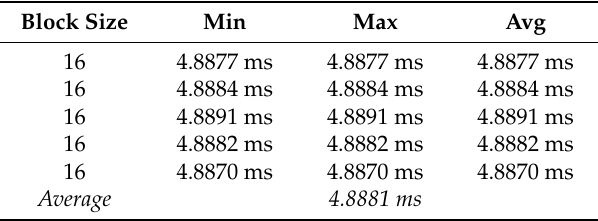
Table 6. Running the nvprof profiler with a block size of 16.